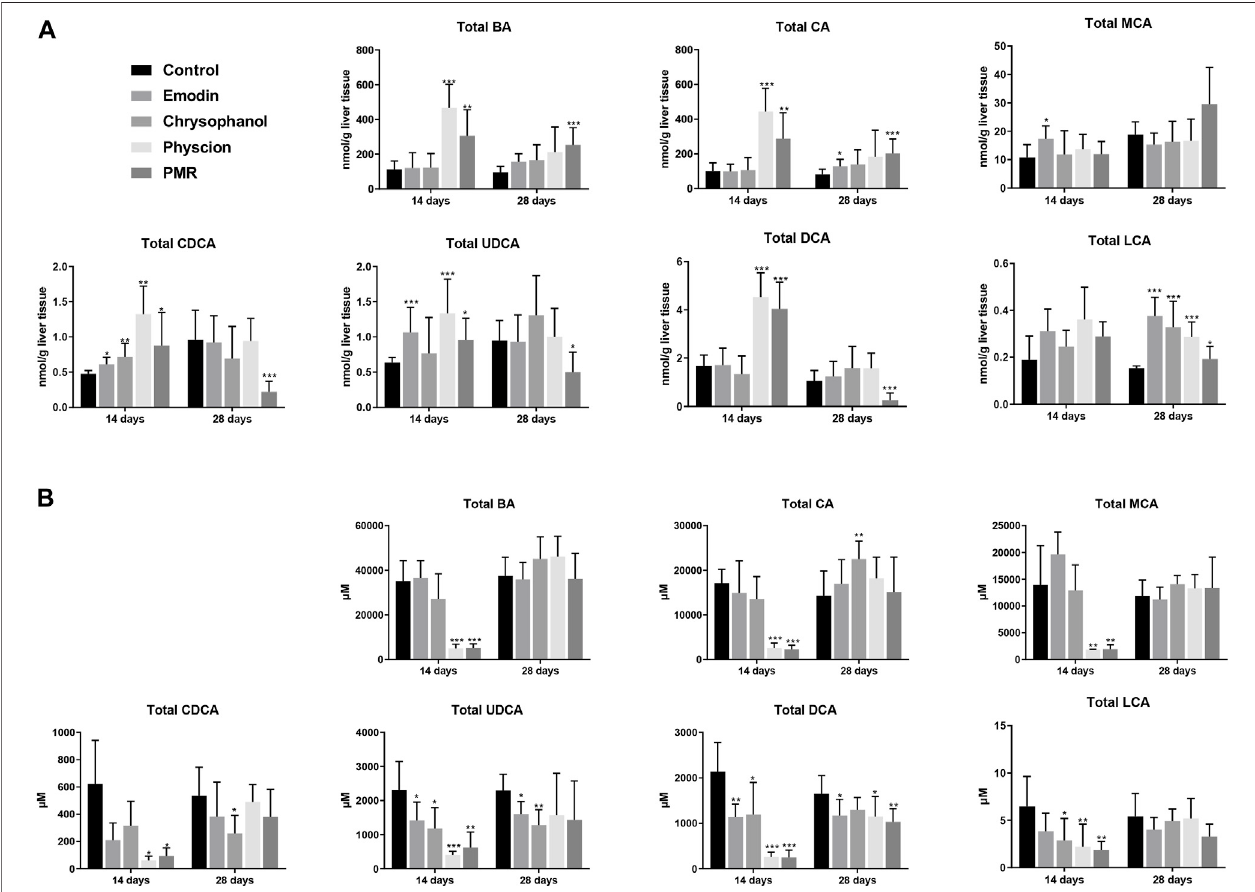
FIGURE4| Comparison ofthetotal BA,total CA,total MCA,total CDCA,total UDCA, total DCA,and total LCAinthe mouseliver (A) and bile (B) betweendifferent groups of mice following 14- or 28-day treatment with anthraquinones or PMR extract. The data are expressed as the mean ± SD (n = 6 – 8). * p < 0.05, ** p < 0.01, *** p < 0.001 compared with control